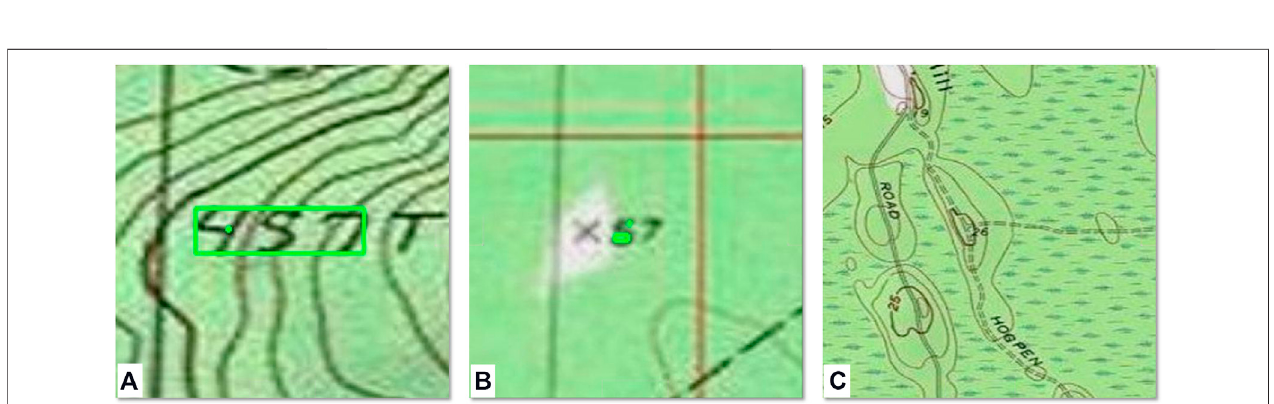
FIGURE 10 | Three error types that the study approach failed to resolve, and ROI output from the RNP (A) contours (or other features) overlap/intersect with elevationtext(alsoshowingimagenoise);althoughthelargerROIisaccurate,thepredictionwastoolowtobeconsideredinthecharactermaskprocess (B) imagenoise, possiblyintroduced during the scanprocess; two small ROIs do not represent the numericstring 57well, and (C) introduction oftoo many other features in zoomed out images (also showing overlapping features); no proposals were generated.